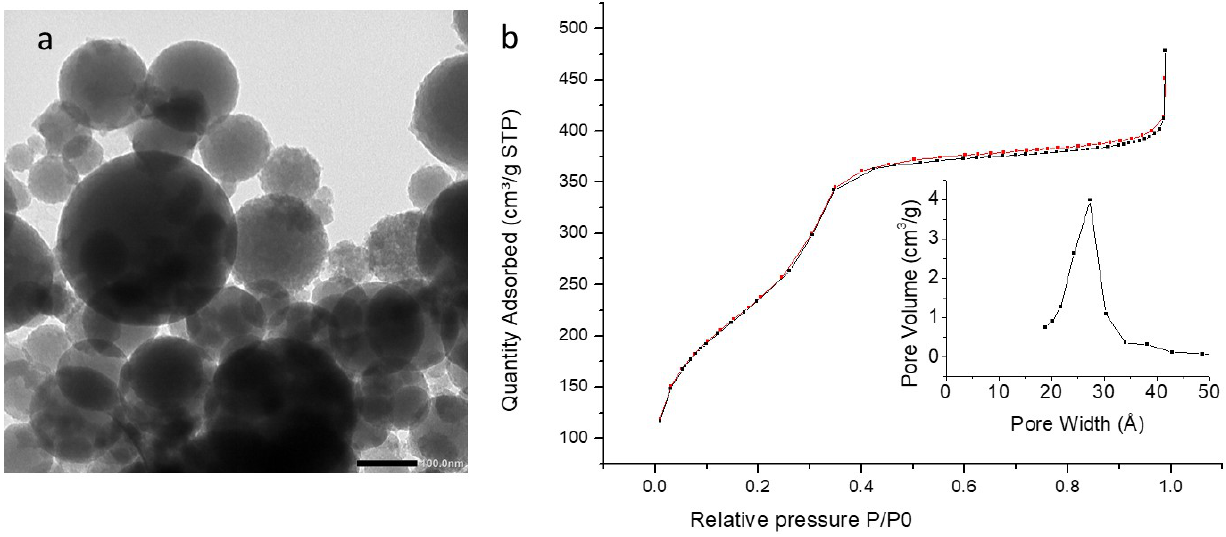
Figure 4. ( a ) TEM image of PyPMO 6 NPs scale bar 100 nm. ( b ) Nitrogen adsorption–desorption at 77 K. Insert BJH desorption (dV/dlog(w)) Pore Volume.